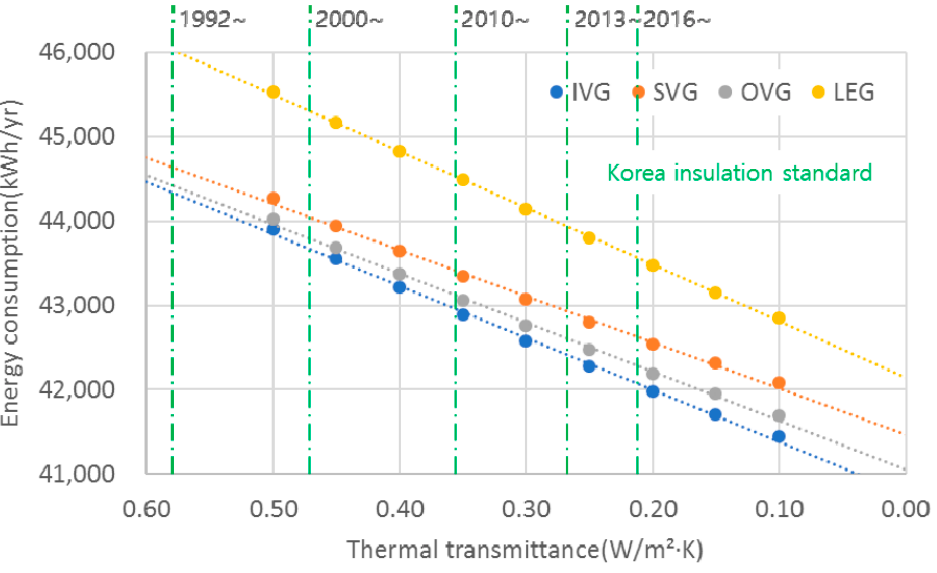
Figure 16. Changes in energy consumption due to insulation enhancement in office